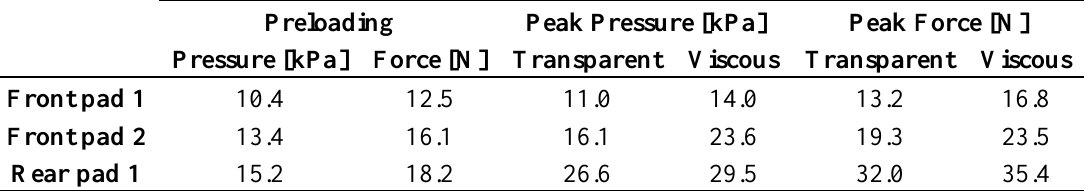
Table 5. Peak pressure and force on the pads, in the two conditions shown in Figure